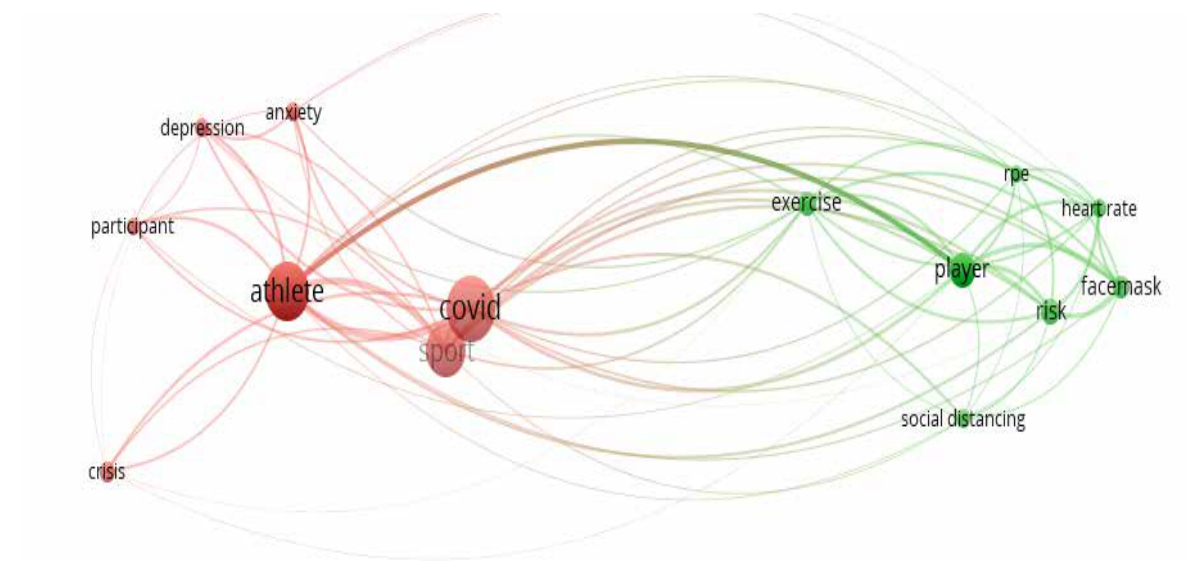
Figure 6. Network mapping of the most frequent terms in the title and abstract literature, the result show that researches in the field sport science conducted to investigate sports’ staffs’ depression, crisis, and anxiety and physical activity. Most of the studies held concerning with football game. Moreover, most of the studies dealt with pandemic, sports medicine, exercise, immunity, etc. indicated that the COVID-19 pandemic has influenced negatively on the sports participation or activities as well as the life and health of